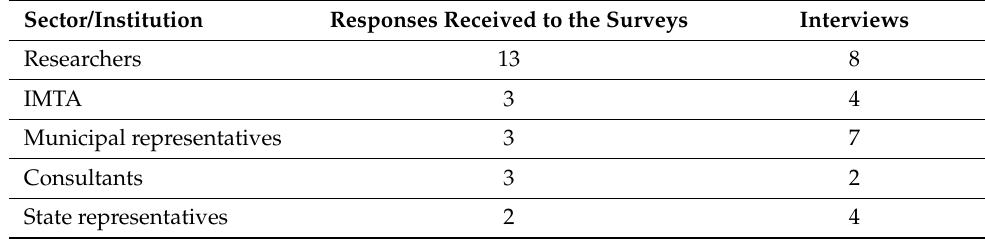
Table 2. Number of interviews and surveys